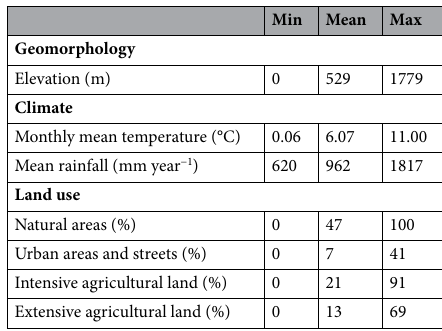
Table 2. Minimum (min), mean and maximum (max) values per cell grid for elevation, climate and land use